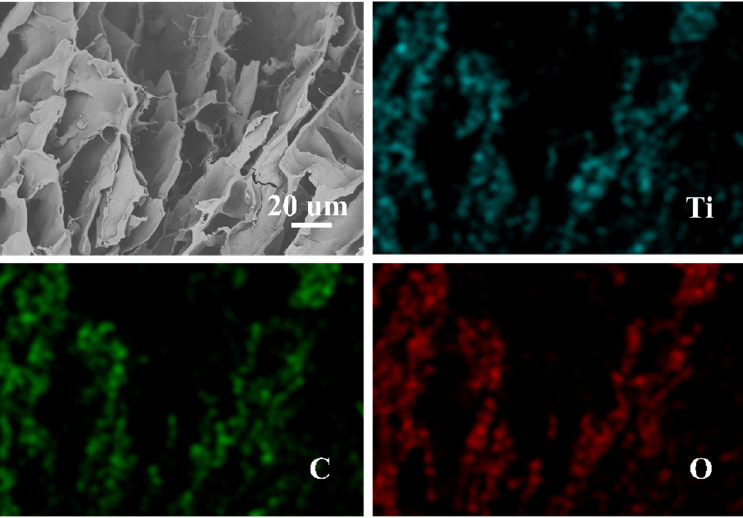
Figure 2. Magnified SEM images of the HTO/CA and SEM-EDS mapping of Ti, C, and O.